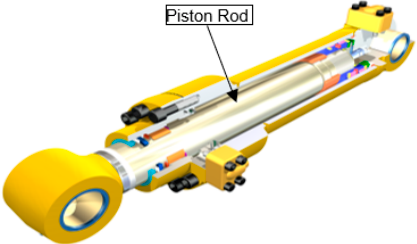
Figure 1. Hydraulic cylinder.